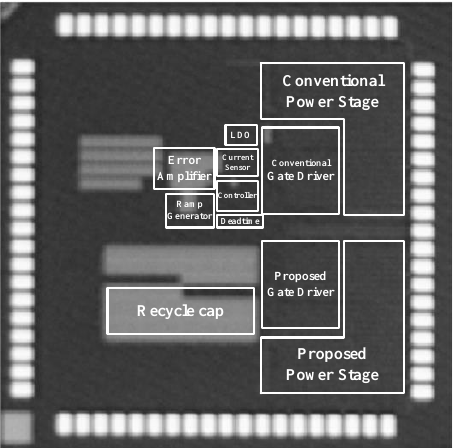
Figure 7. Microphotograph of the test chip.